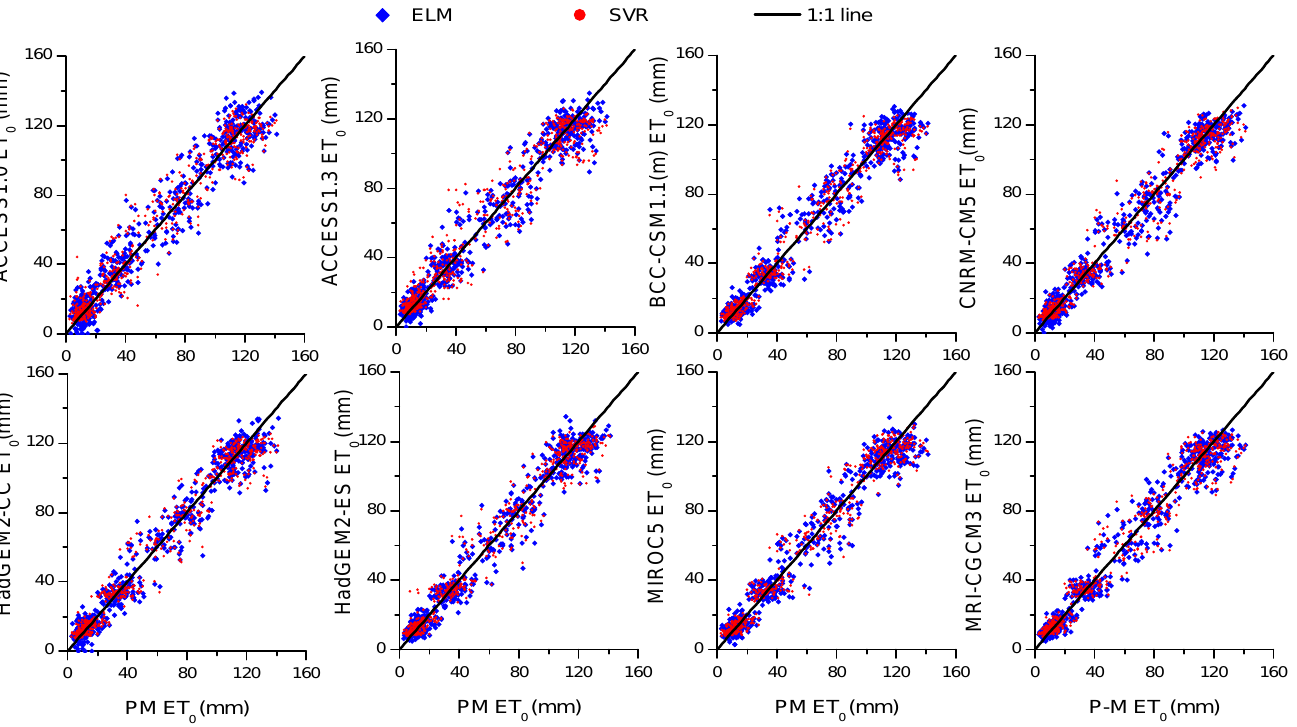
Figure 3. Scatter plots for the historical ET 0 (1961–2005) calculated by the Penman–Monteith equation with the observed meteorological data downscaled by the extreme-learning machine (ELM) and support vector regression (SVR) approaches derived for the eight GCM outputs.